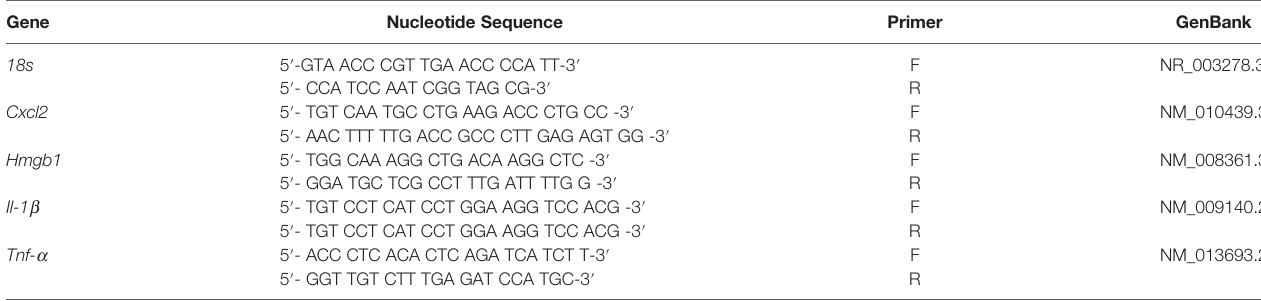
Gene Nucleotide